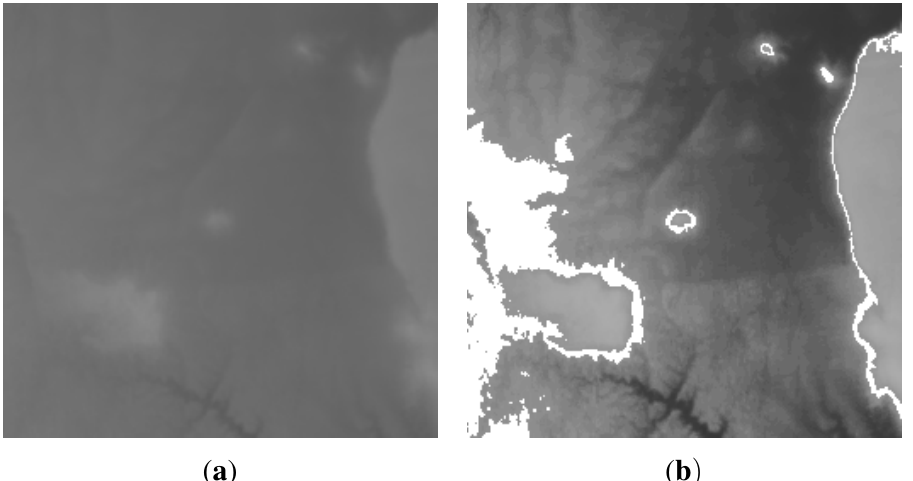
Figure 6. ( a ) A section of the Grand Canyon height map; ( b ) A contour at 116 units drawn over 2D map in ( a